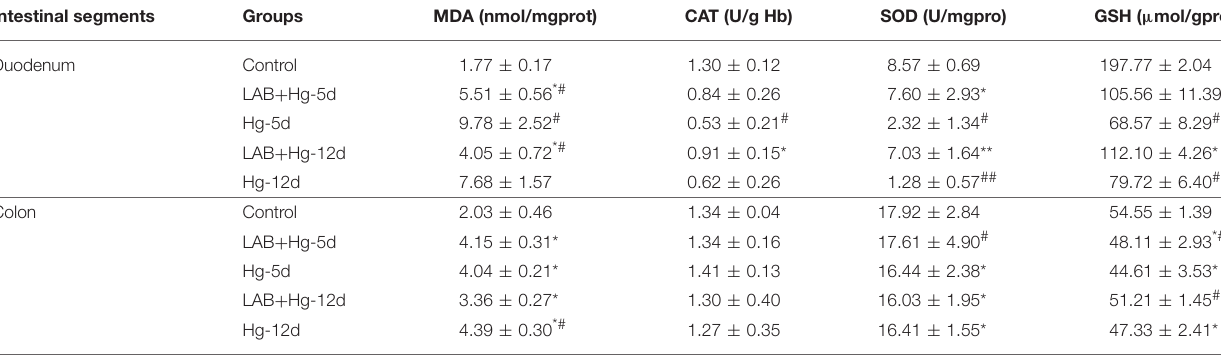
TABLE 3 | Antioxidant Indices in Duodenum and Jejunum Results. Intestinal